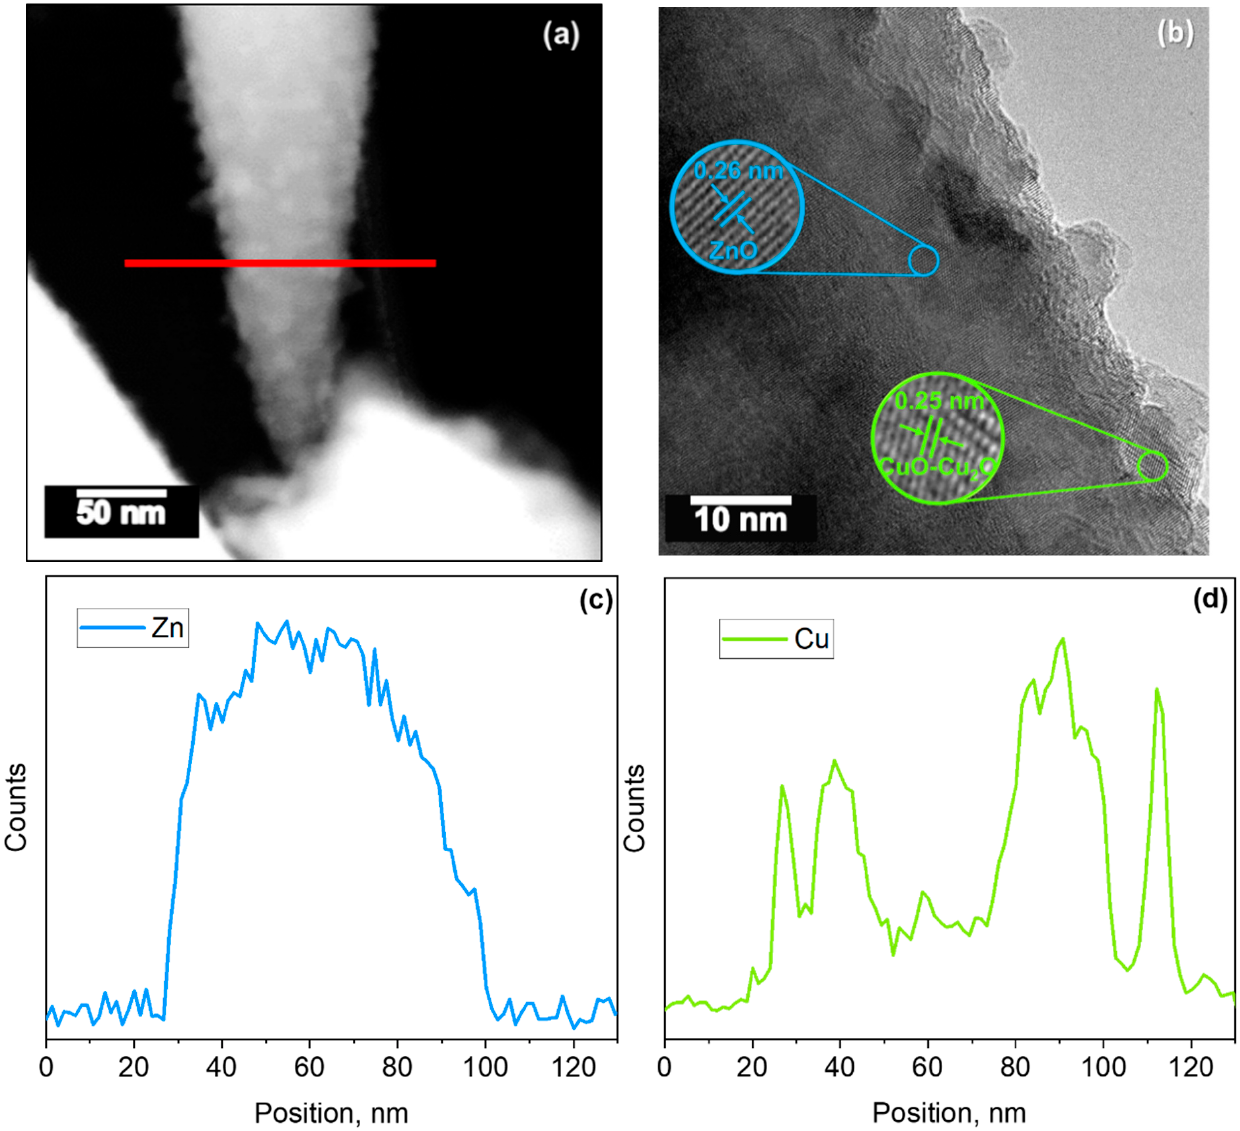
Figure 8. TEM images of a copper-modified ZnO rod. ( a ) Low-magnification TEM image, ( b ) high-resolution TEM image, and EDS line-scan profiles of the marked line in ( a ) corresponding to ( c ) Zn and ( d ) Cu.